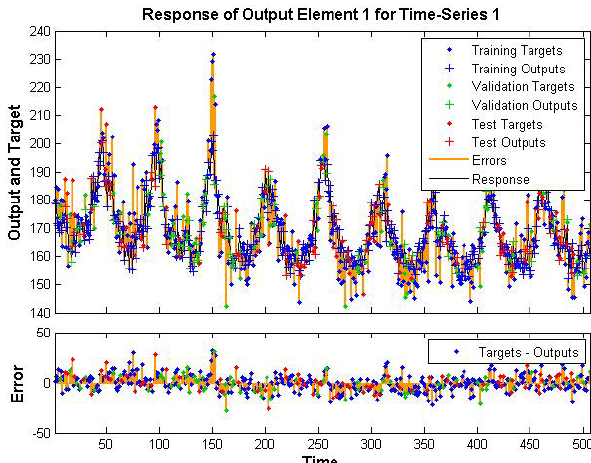
Figure 19. The response of the output